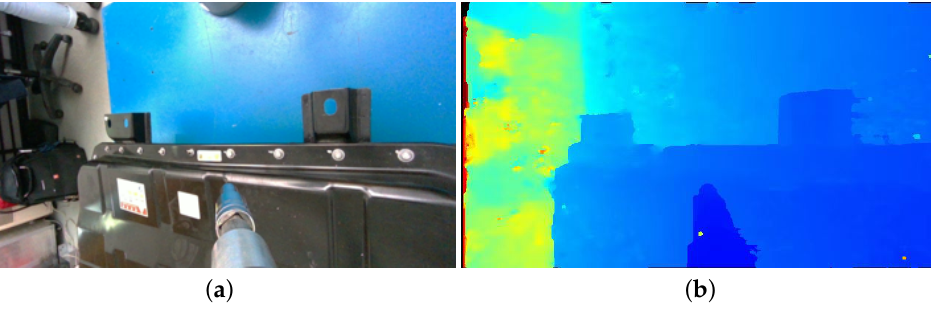
Figure 14. RGB images ( a ) and depth images ( b ) captured by the vision sensor in the initial state. The screws are initially detected based on the RGB image using the target detection model to obtain approximate prediction boxes for the screw, which are not accurate at this stage, Figure 15. These prediction boxes are selected to approximate the pixel area of the screw in the image.